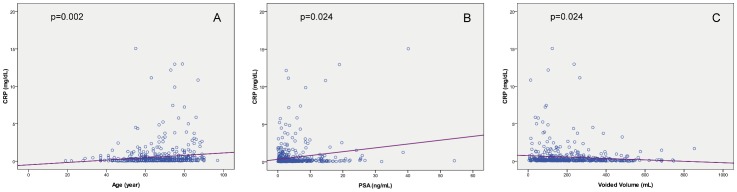
Serum CRP levels are significantly correlated with (A) age, (B) serum PSA levels, and (C) voided volume.